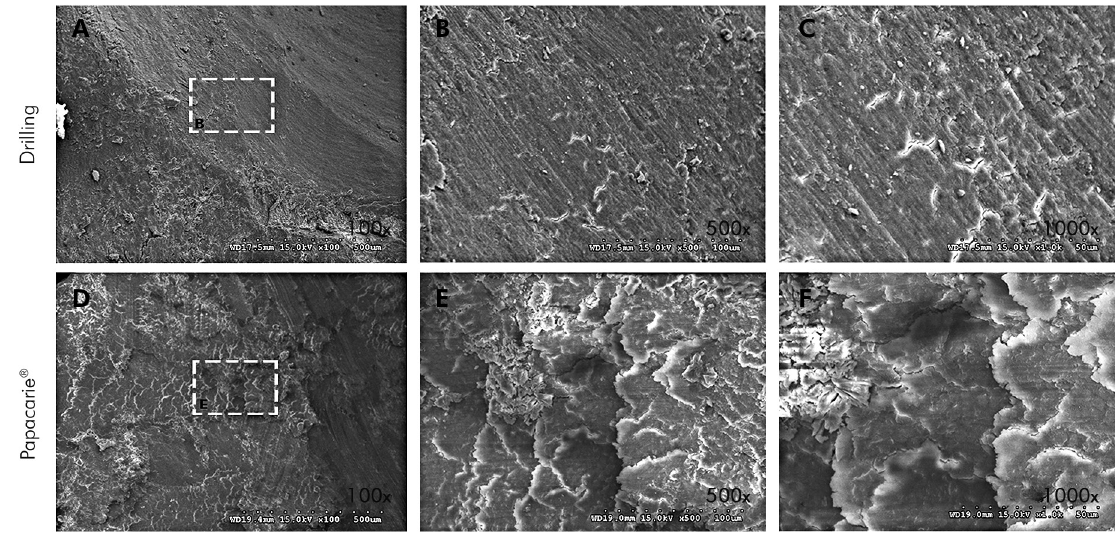
(A,B,C) SEM images of the drilling group at 100x, 500x, and 1000x magnification, respectively. (D,E,F) SEM images of the CMCR group at 100x, 500x, and 1000x magnification, respectively. Figure 1. SEM images of the residual dentin after caries